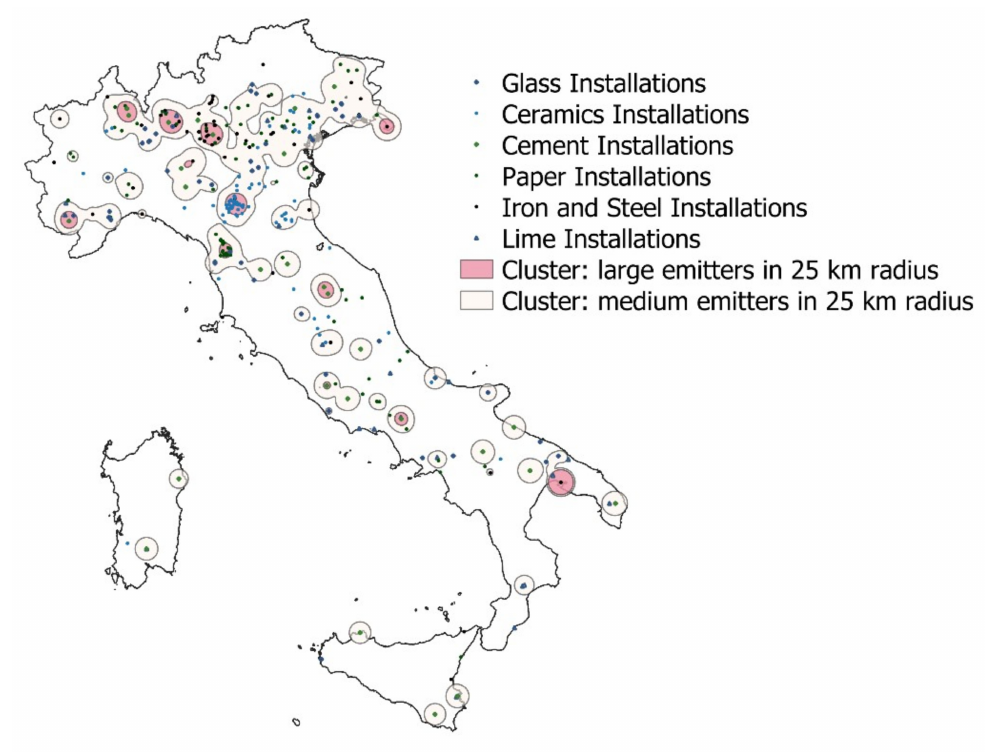
Figure 5. Clusters of industrial greenhouse gas emitters representing large and medium emitters.